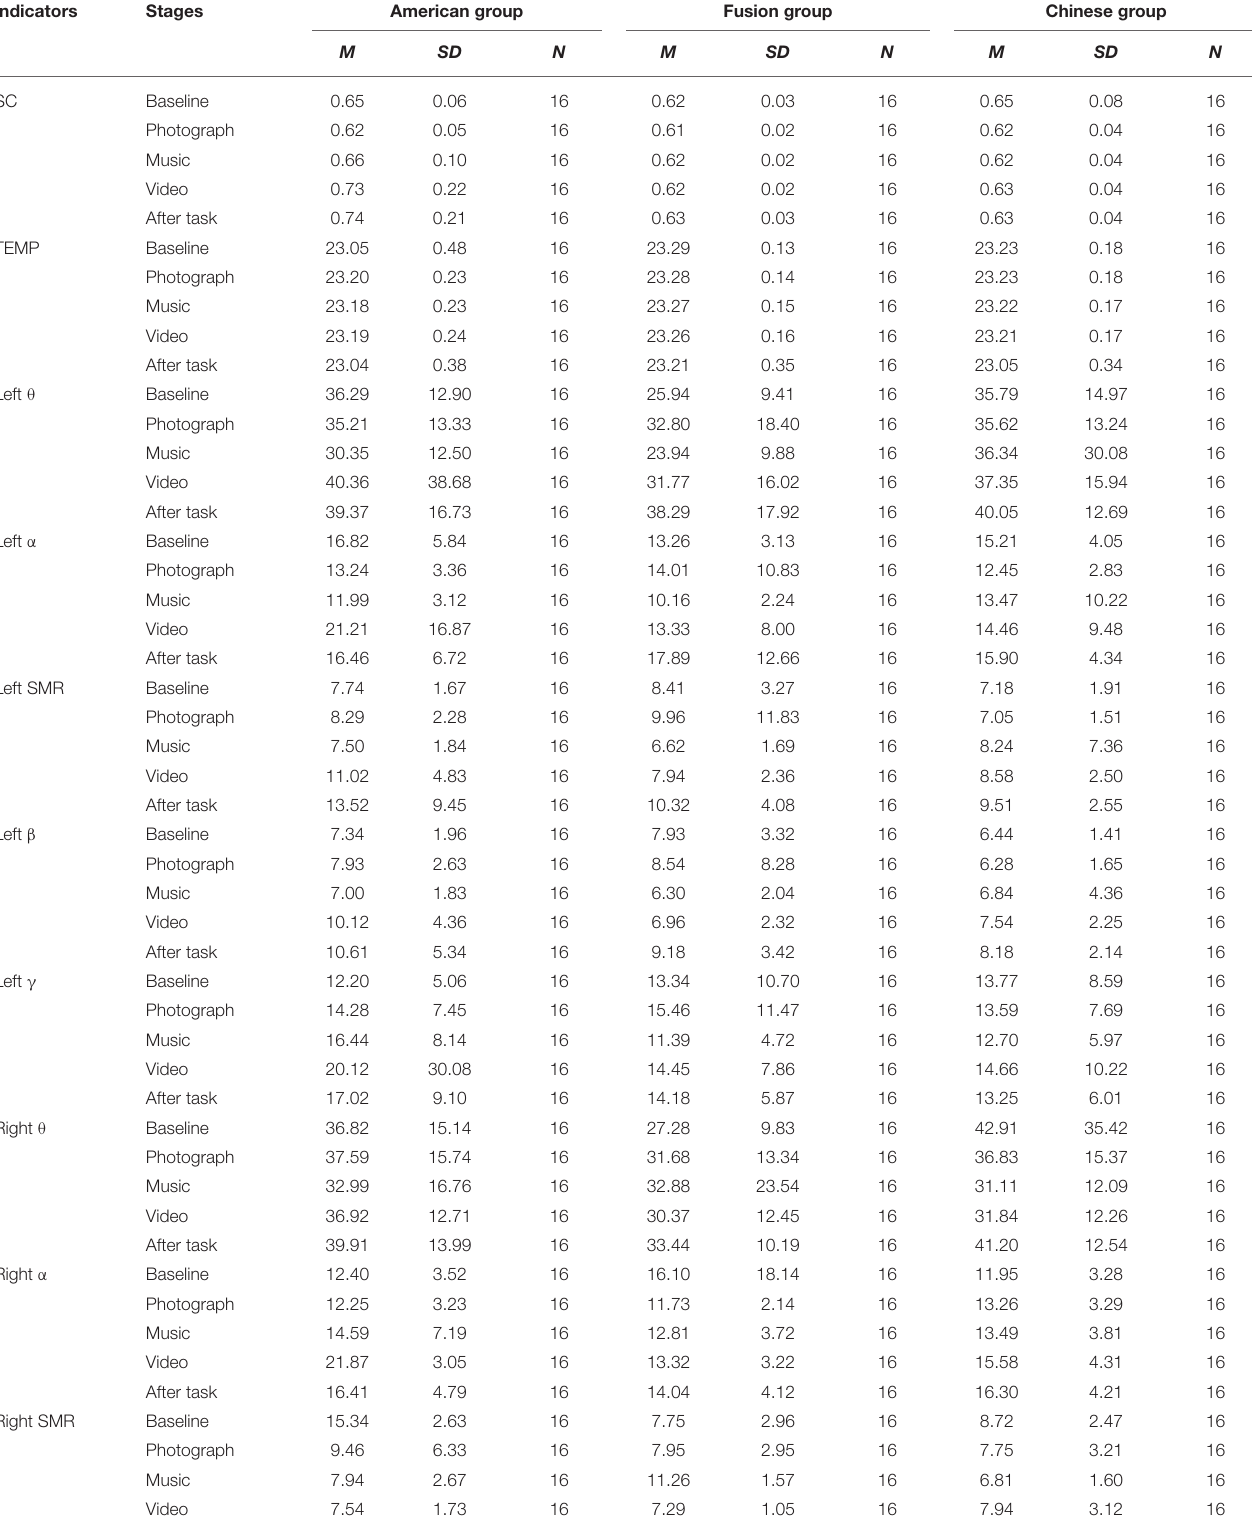
TABLE 2 | In the three experimental conditions, participants watched music video and TV video in the baseline stage. Indicators Stages American group Fusion